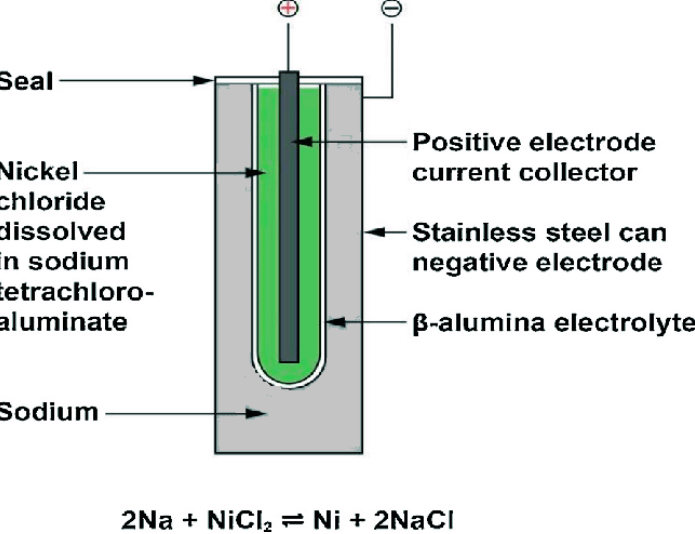
Figure 9. Chemistry and principal components of a sodium–nickel chloride battery.